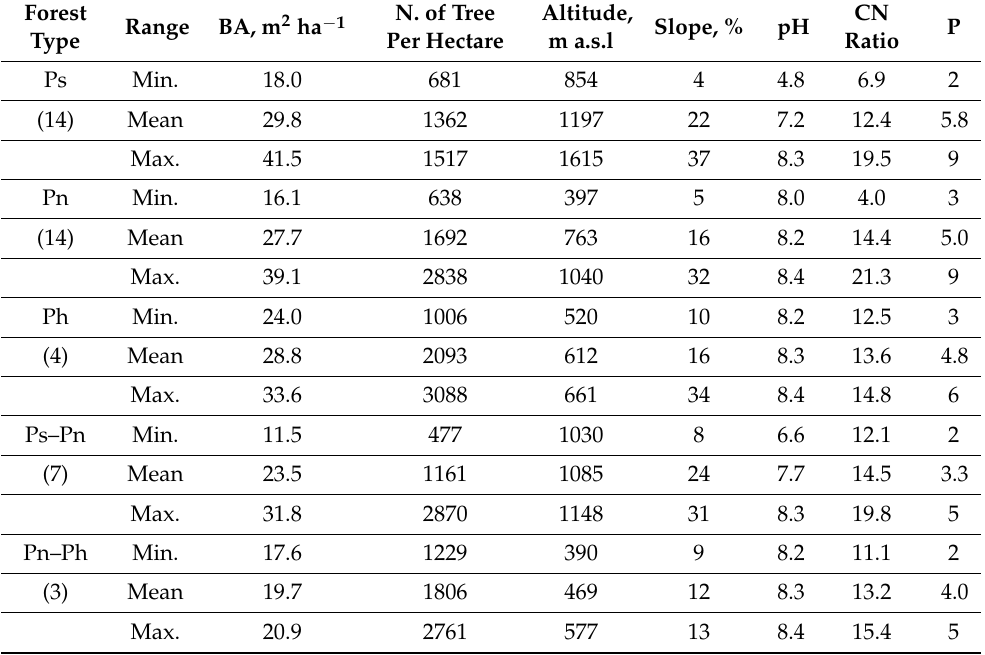
Table 1. Table summarizing the main features of the study plots: BA (Basal area), Number of trees per hectare, Altitude, Slope, pH, CN ratio and P (Phosphorus). Ps: P. sylvestris , Pn: P. nigra , Ph: